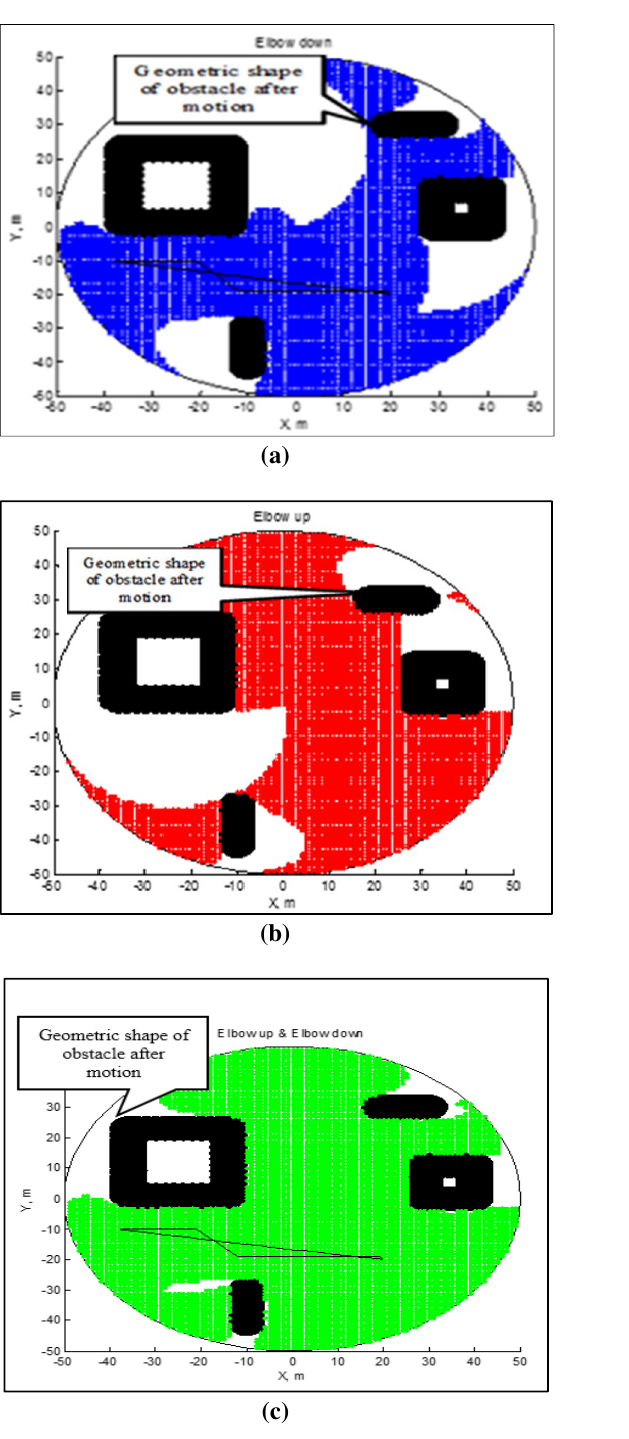
Fig. 6. FCS for known obstacle position dynamic environment where (a) represents elbow down, (b) represents elbow up and (c) represents the gathering between elbow up and elbow